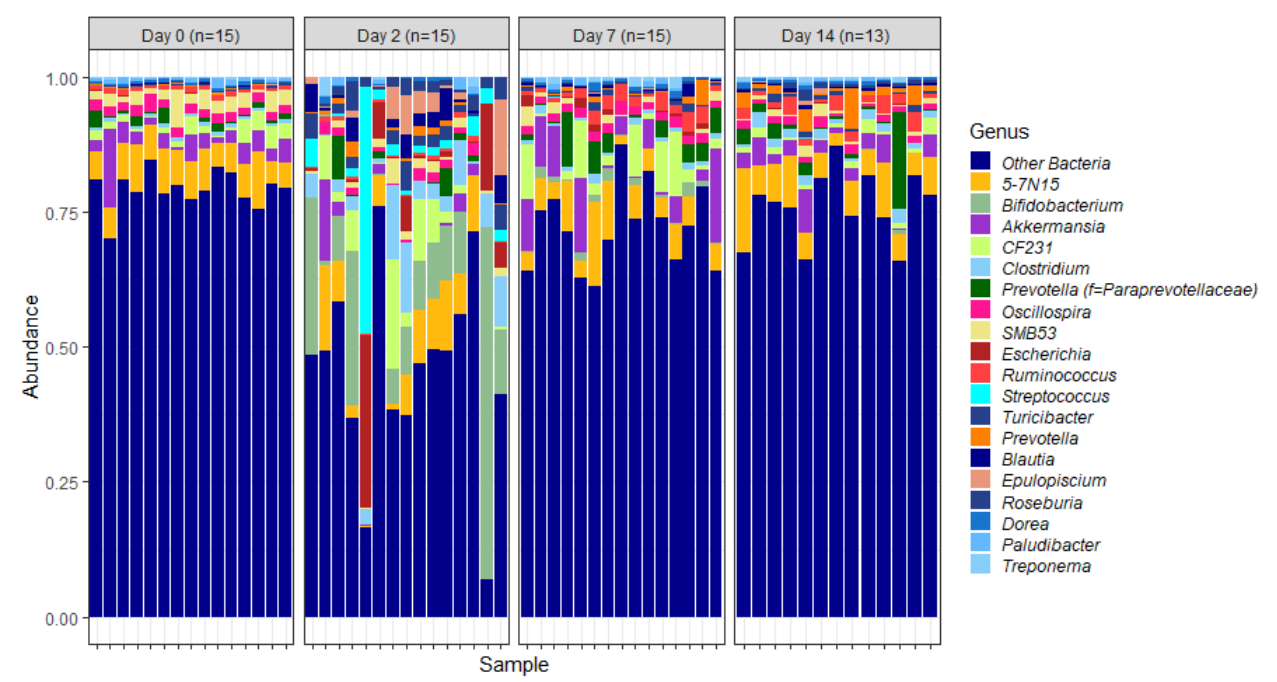
Figure 3. Genus-level faecal microbiota assortment. Bar chart showing the average relative abundance of all bacterial OTUs taxonomically classified at genus level in each animal sampled either on the day of induction (day 0) or 2, 7 and 14 days post induction.